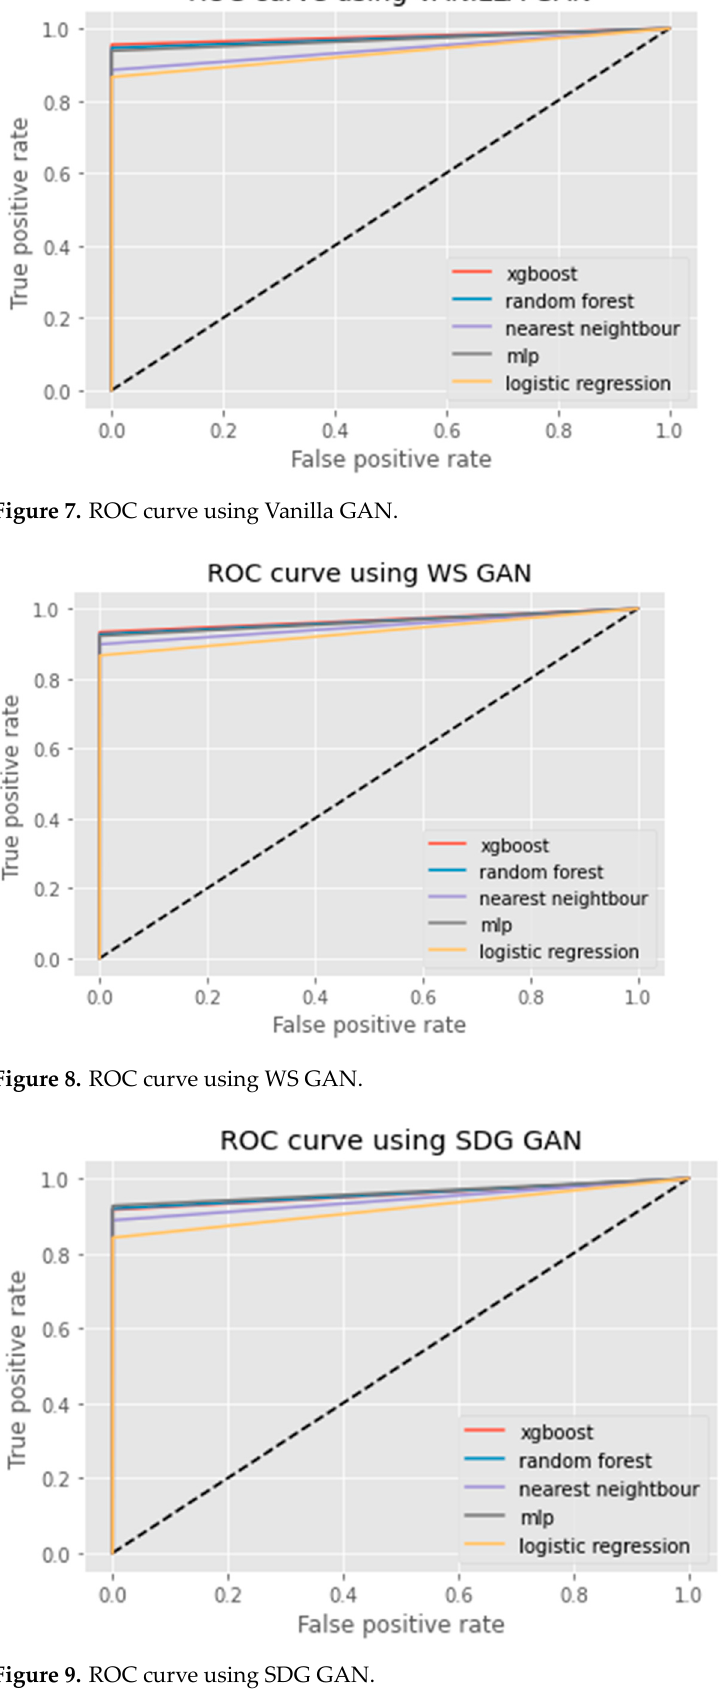
Figure 9. ROC curve using SDG GAN.